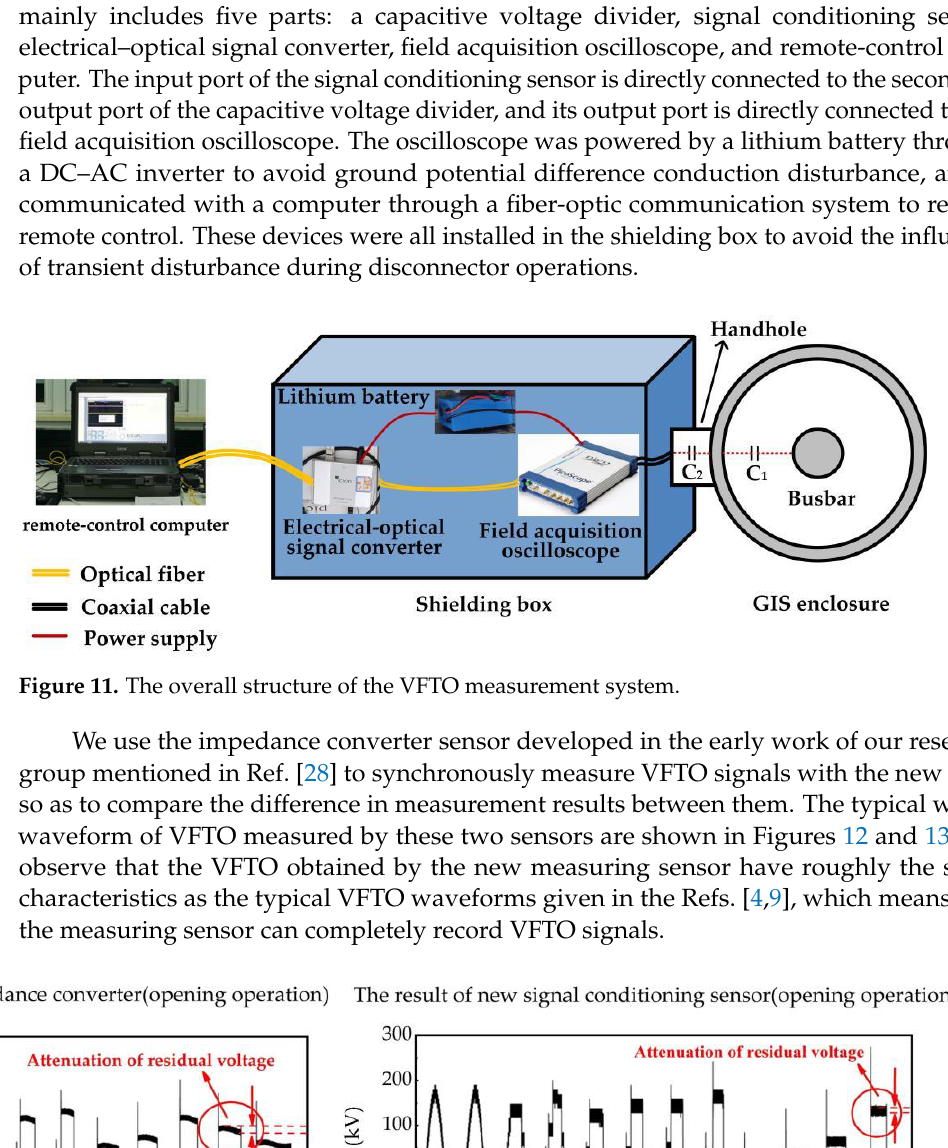
Figure 10. Schematic diagram of the 220 kV GIS test circuit.